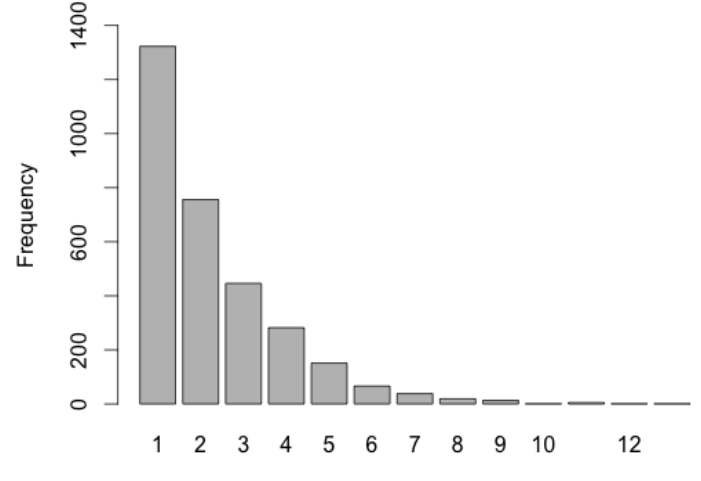
Figure 2. Frequency distribution of the number of species obtained from each sampling